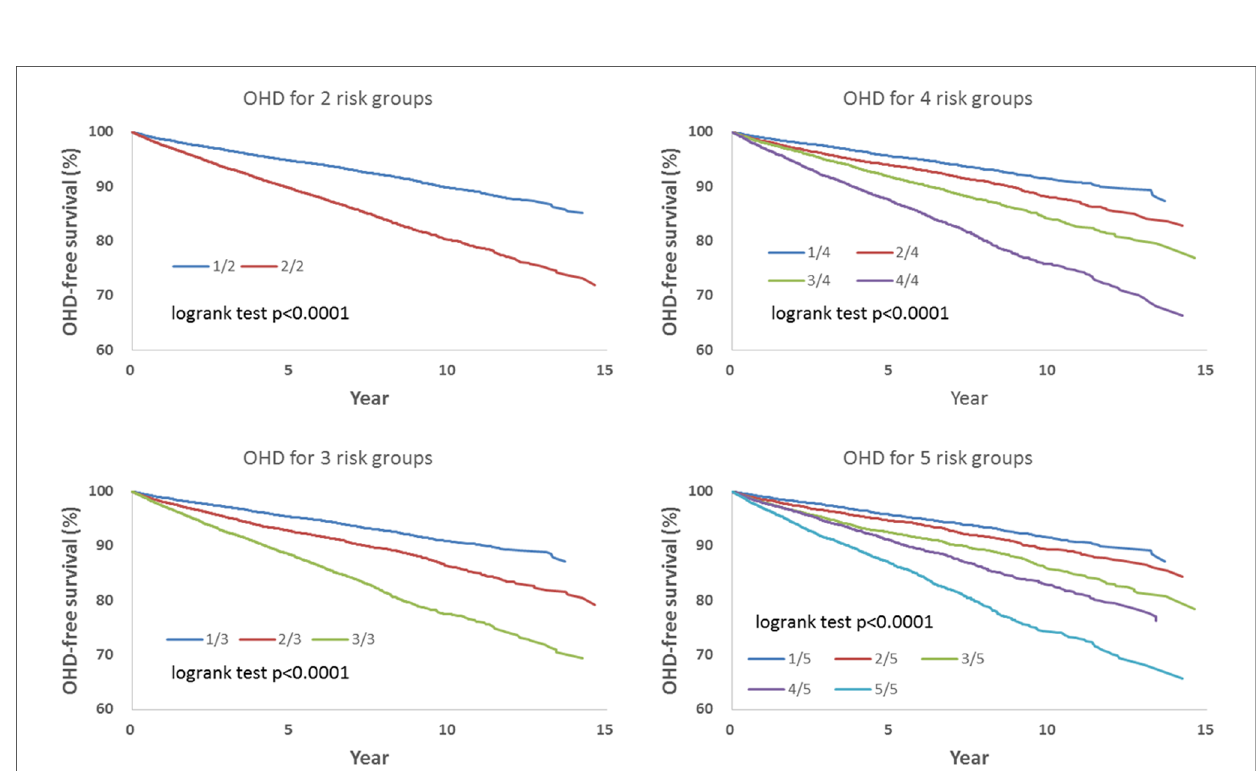
FIGURE 4 Based on Tables 2 , 3 , the hazard-based risk grouping effectively strati fi ed irradiated breast cancer patients in the endpoint of other heart diseases (OHD; p <0.0001 in all